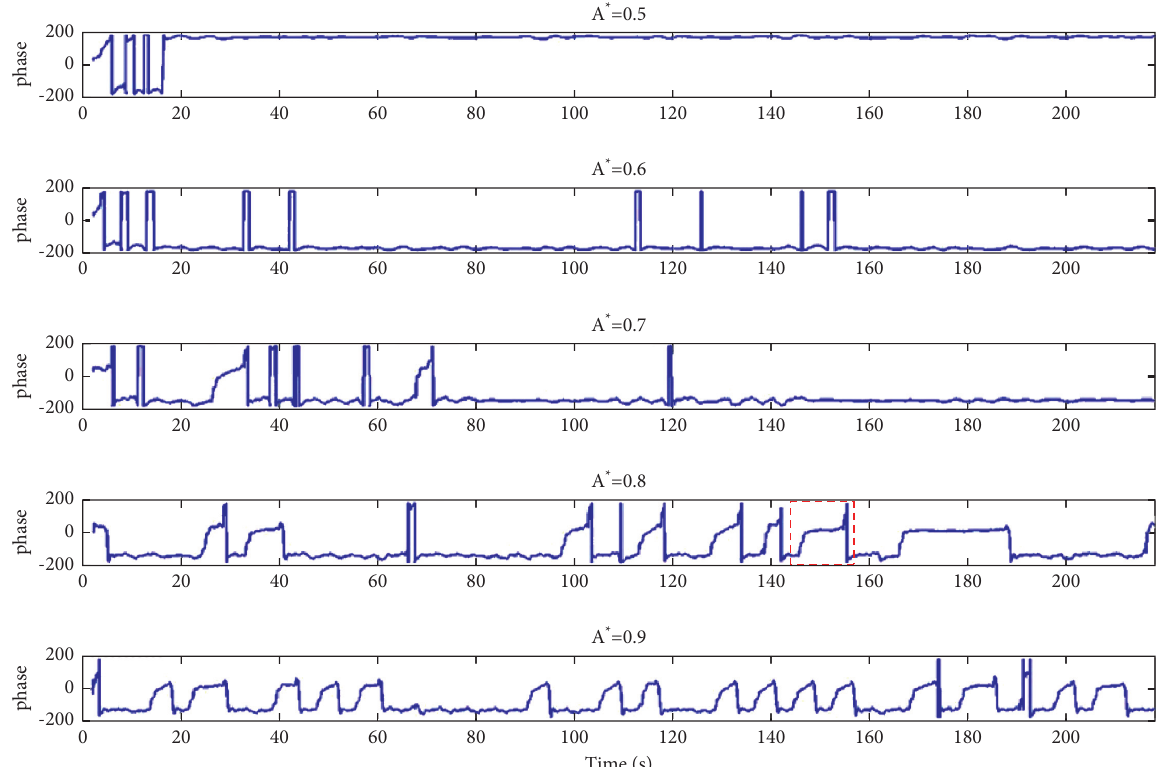
Figure 6: Vortex field of 2 P O mode at the positive part of phase angle.